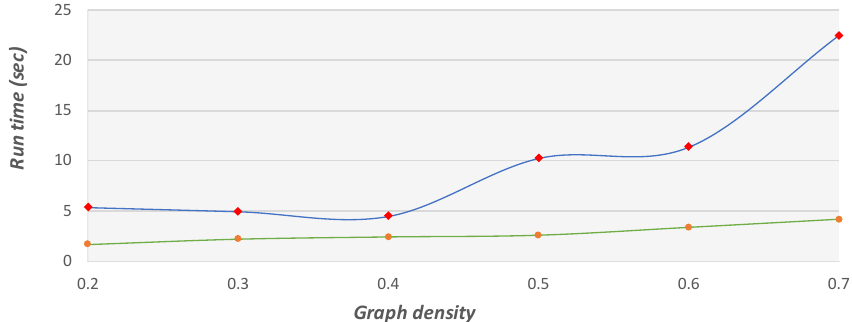
Figure 16. Run time comparison on graphs with 200 vertices at different densities. This graph presents the run time of the 2-factor approximation method ( green ) and the GA ( blue ).